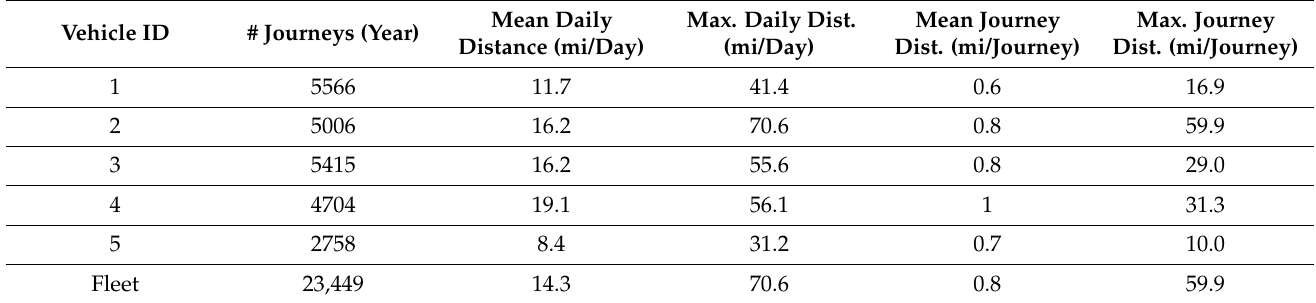
Table 2. Descriptive statistics of vehicle journeys and travel distance.